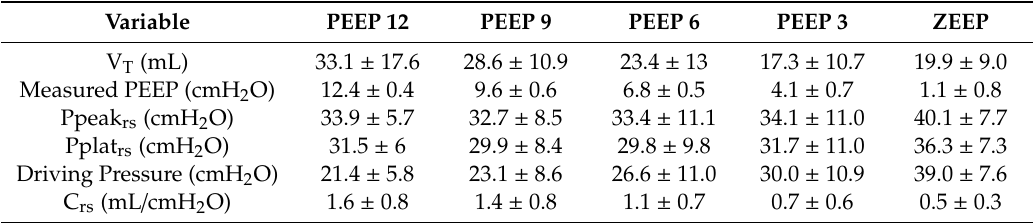
Table 1. Ventilatory data. Data are expressed as mean ±